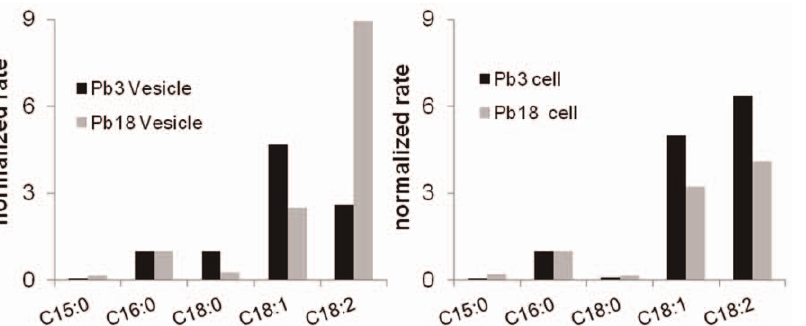
Figure 2. Phospholipid fatty acid analysis of Pb3 and Pb18 extracellular vesicles and whole yeast cells. Fatty acids from phospholipid- enriched fractions resulting from silica gel-60 column separation were released with NH 4 OH, methylated with methanolic HCl, and analyzed by GC-